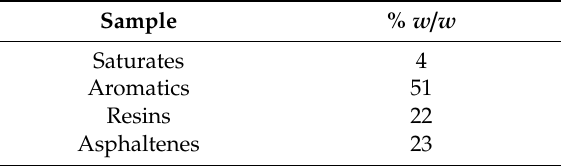
Table 1. Group composition of pristine